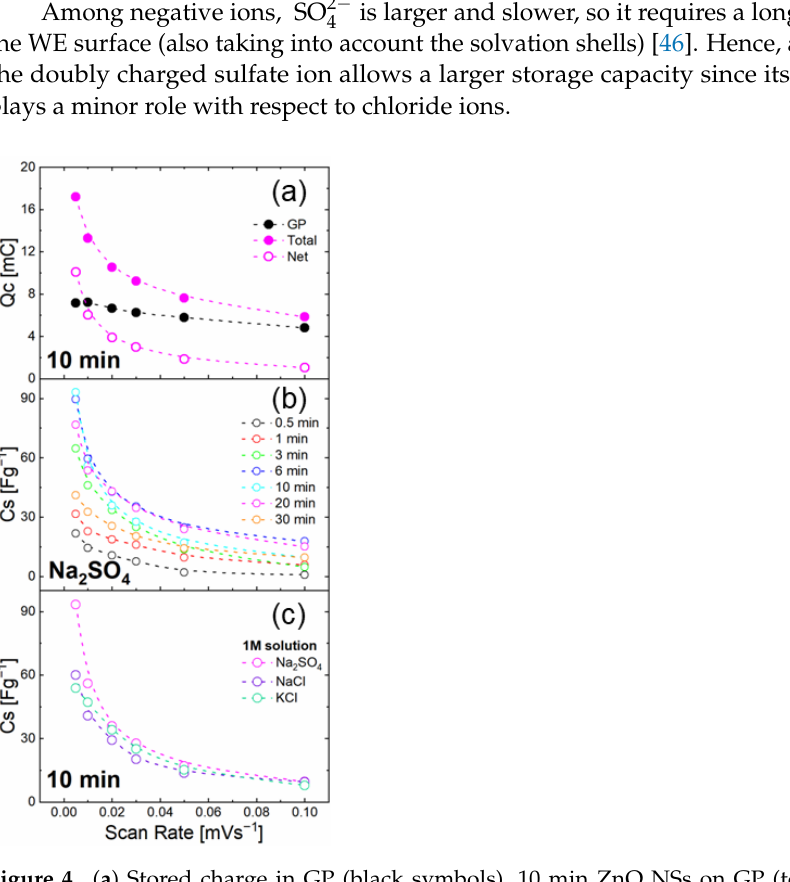
Figure 4. ( a ) Stored charge in GP (black symbols), 10 min ZnO NSs on GP (total, full magenta symbols) and their difference (net) (open magenta symbols); ( b ) specific capacitances extracted from CV for 0.5, 1, 2, 3, 6, 10, 20, and 30 min ZnO NSs in Na 2 SO 4 ; and ( c ) specific capacitances of 10 min ZnO in NaCl, KCl, and Na 2 SO 4 (purple, green, and magenta symbols respectively).